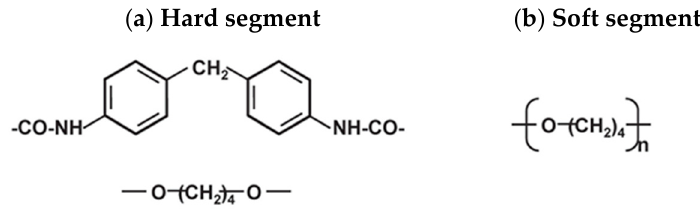
Figure 1. Chemical Structure of Pellethane 2363 80AE. ( a ) Methylene diphenyl isocyanate and 1, 4 ‐ butanediol, a chain extender hard segments and ( b ) poly (tetramethylene glycol) soft segments. Hot ‐ melt extrusion (HME) process is typically used in manufacturing such profiles.